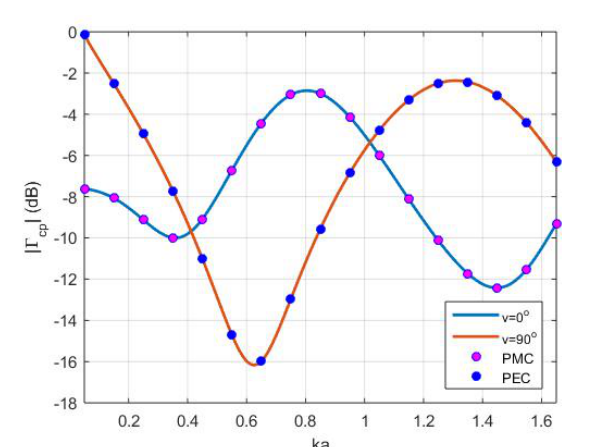
Figure 3: Comparing the variations of reflection coefficient magnitudes with ka for buried PEMC circular cylinders of radius a , with d =2.5 cm, ρ 0 =3.0 cm, and η 0 / η 1 = 0.4, for ν =0 o and ν =90 o , with those for equivalent PMC and PEC cylinders.